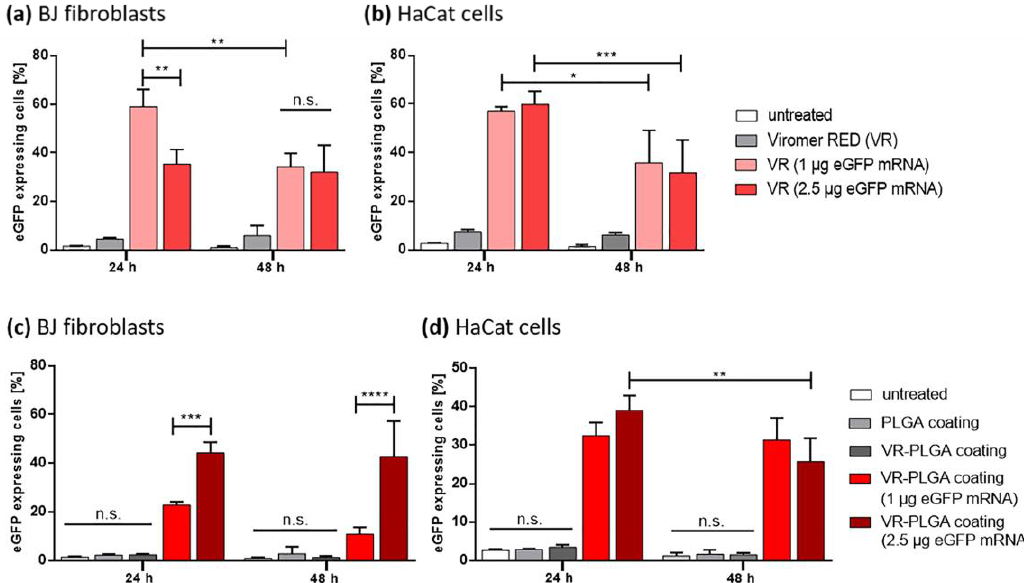
Figure 3. Determination of the transfection efficiencies 24 or 48 h after direct or indirect eGFP mRNA transfection. Flow cytometric analysis 24 or 48 h after the direct transfection of BJ fibroblasts ( a ) or HaCat cells ( b ) with Viromer RED-encapsulated eGFP-encoding mRNA. BJ fibroblasts ( c ) and HaCat cells ( d ) were also analyzed after the indirect transfection via the mRNA-PLGA coating ( n = 4; * * * * p < 0.0001, * * * p < 0.001, * * p < 0.01, * p < 0.05, n.s. = not significant).